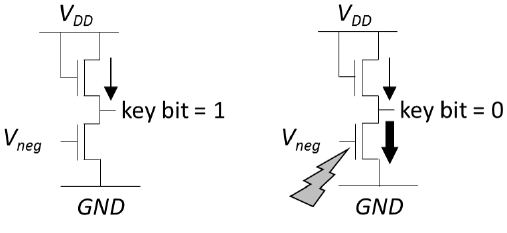
Figure 9: First option for the key programming